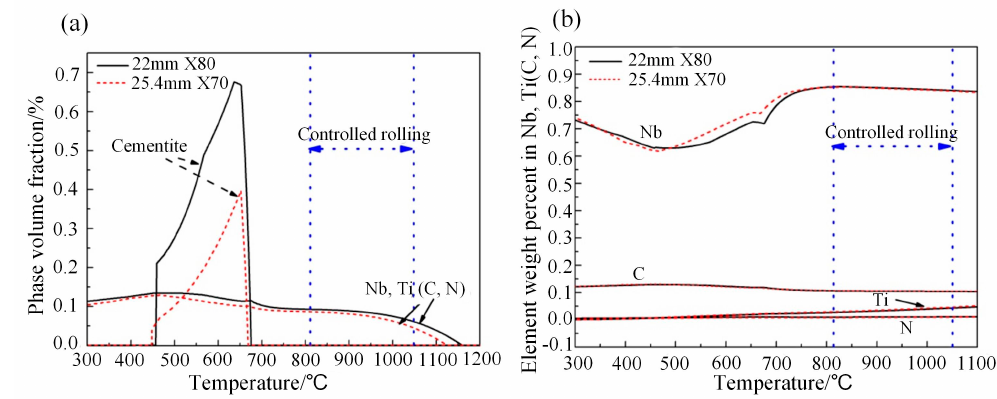
Figure 9. Calculated results obtained using Thermo-Calc software. ( a ) phase volume fraction variation with temperature; ( b ) element weight percent in precipitation variation with temperature.